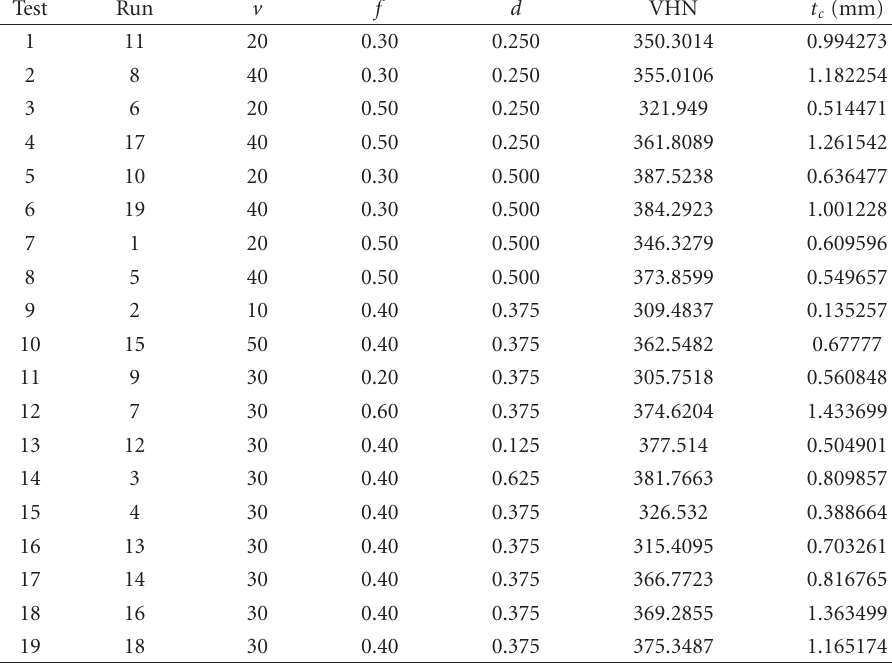
Table 5 . 1 . Average results of thickness and VHN/5/10 measurements per test.